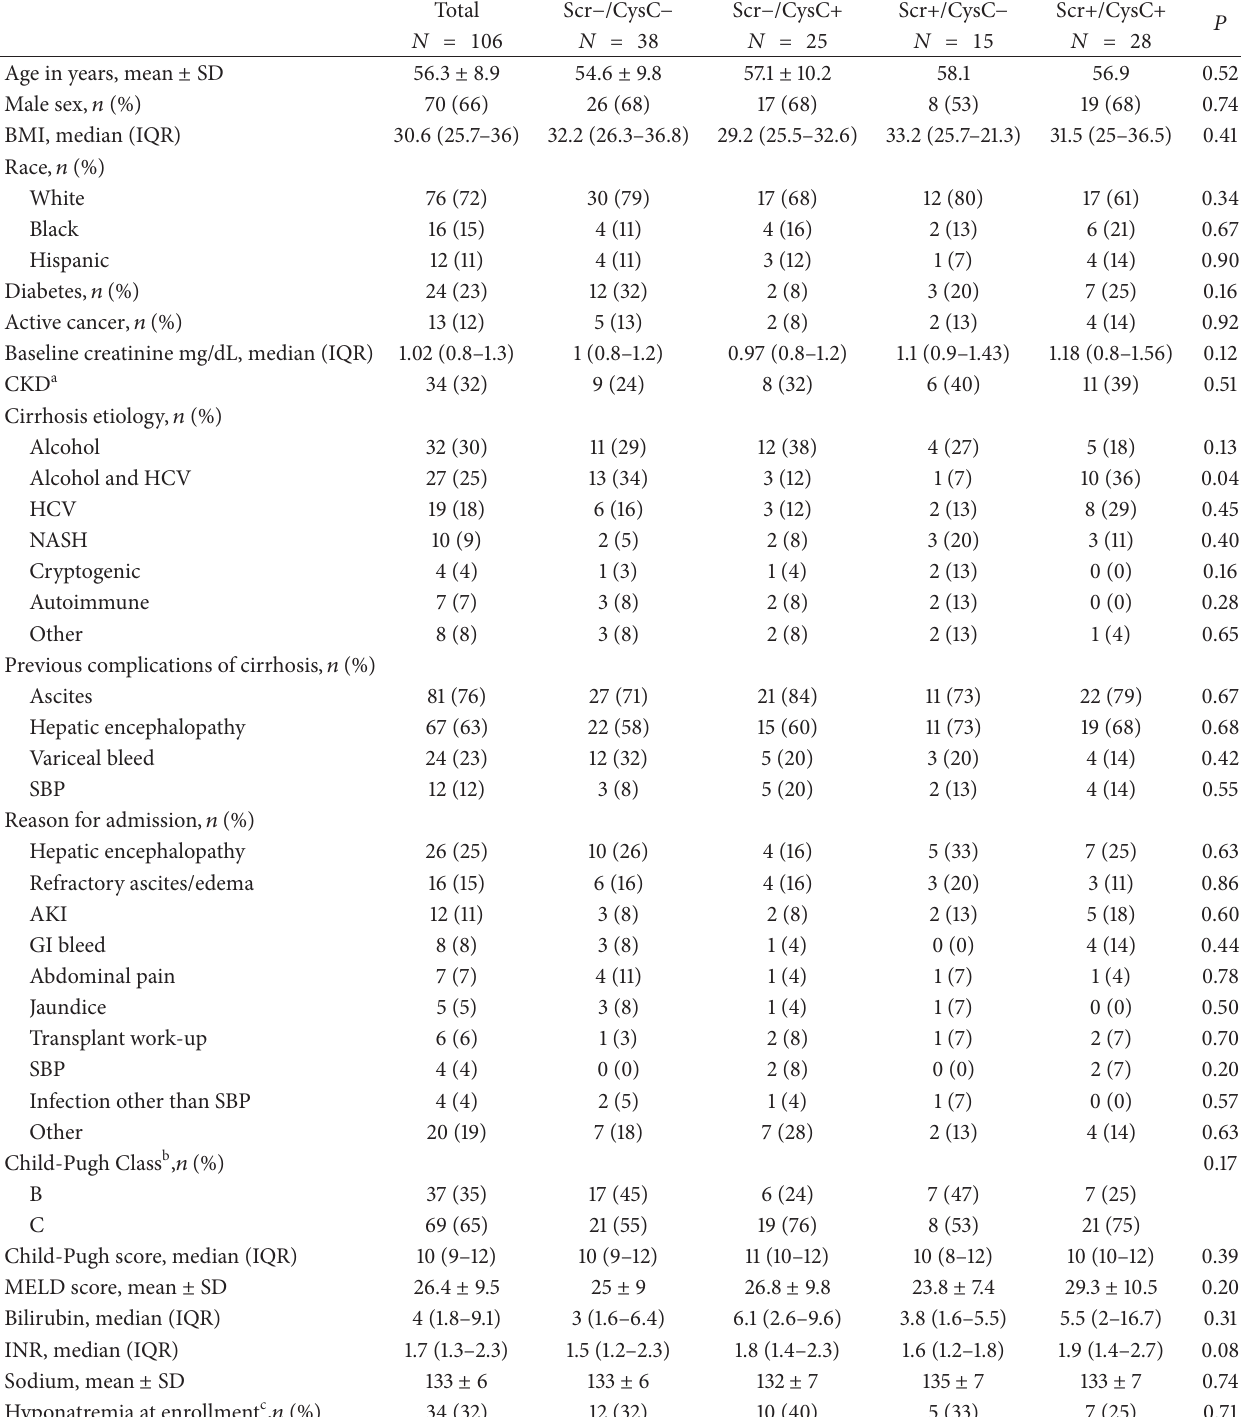
Table 1: Baseline demographic, clinical, and laboratory